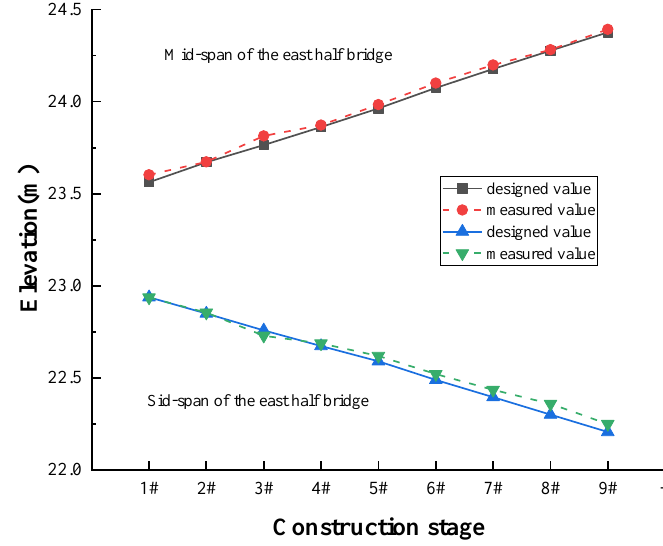
Figure 18. The measured elevation of the